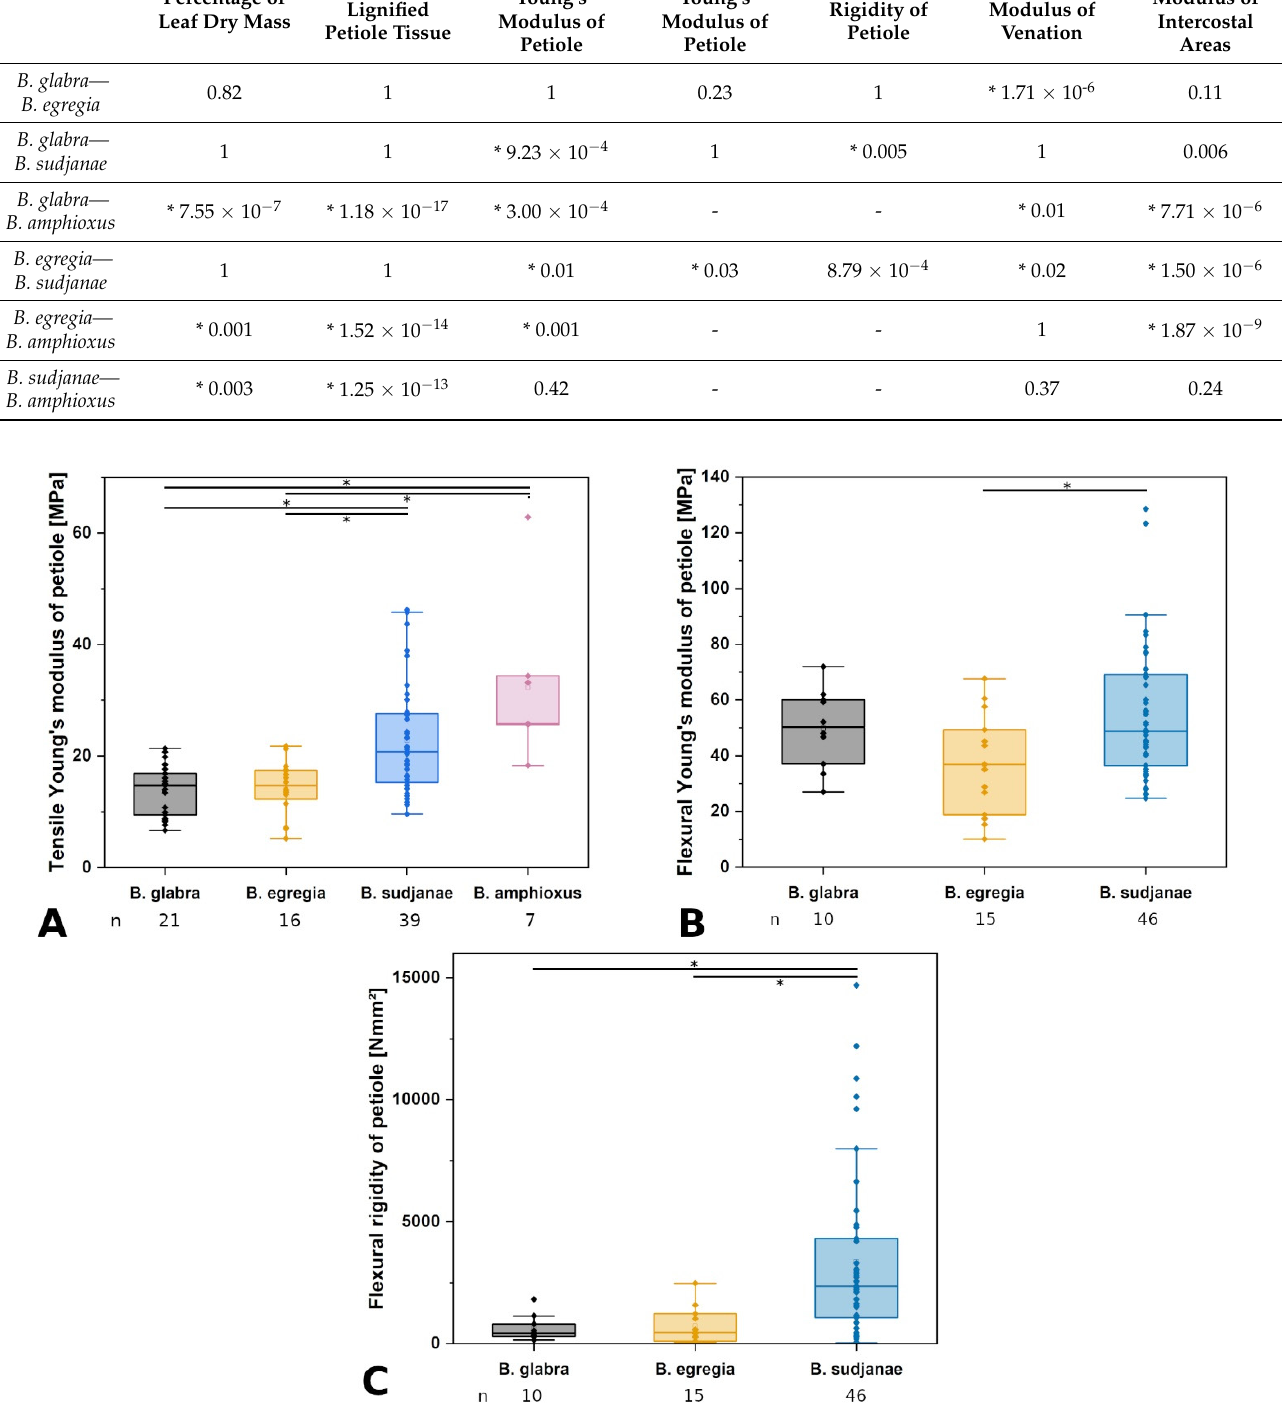
Figure 4. Comparison of mechanical leaf variables in different Begonia species. Tensile ( A ) and flex- ural ( B ) Young’s moduli of petiole in MPa, flexural rigidity of petiole ( C ) in Nmm 2 , tensile Young’s moduli of venation ( D ), and intercostal areas ( E ) in MPa of Begonia glabra , B. egregia , B. sudjanae, and